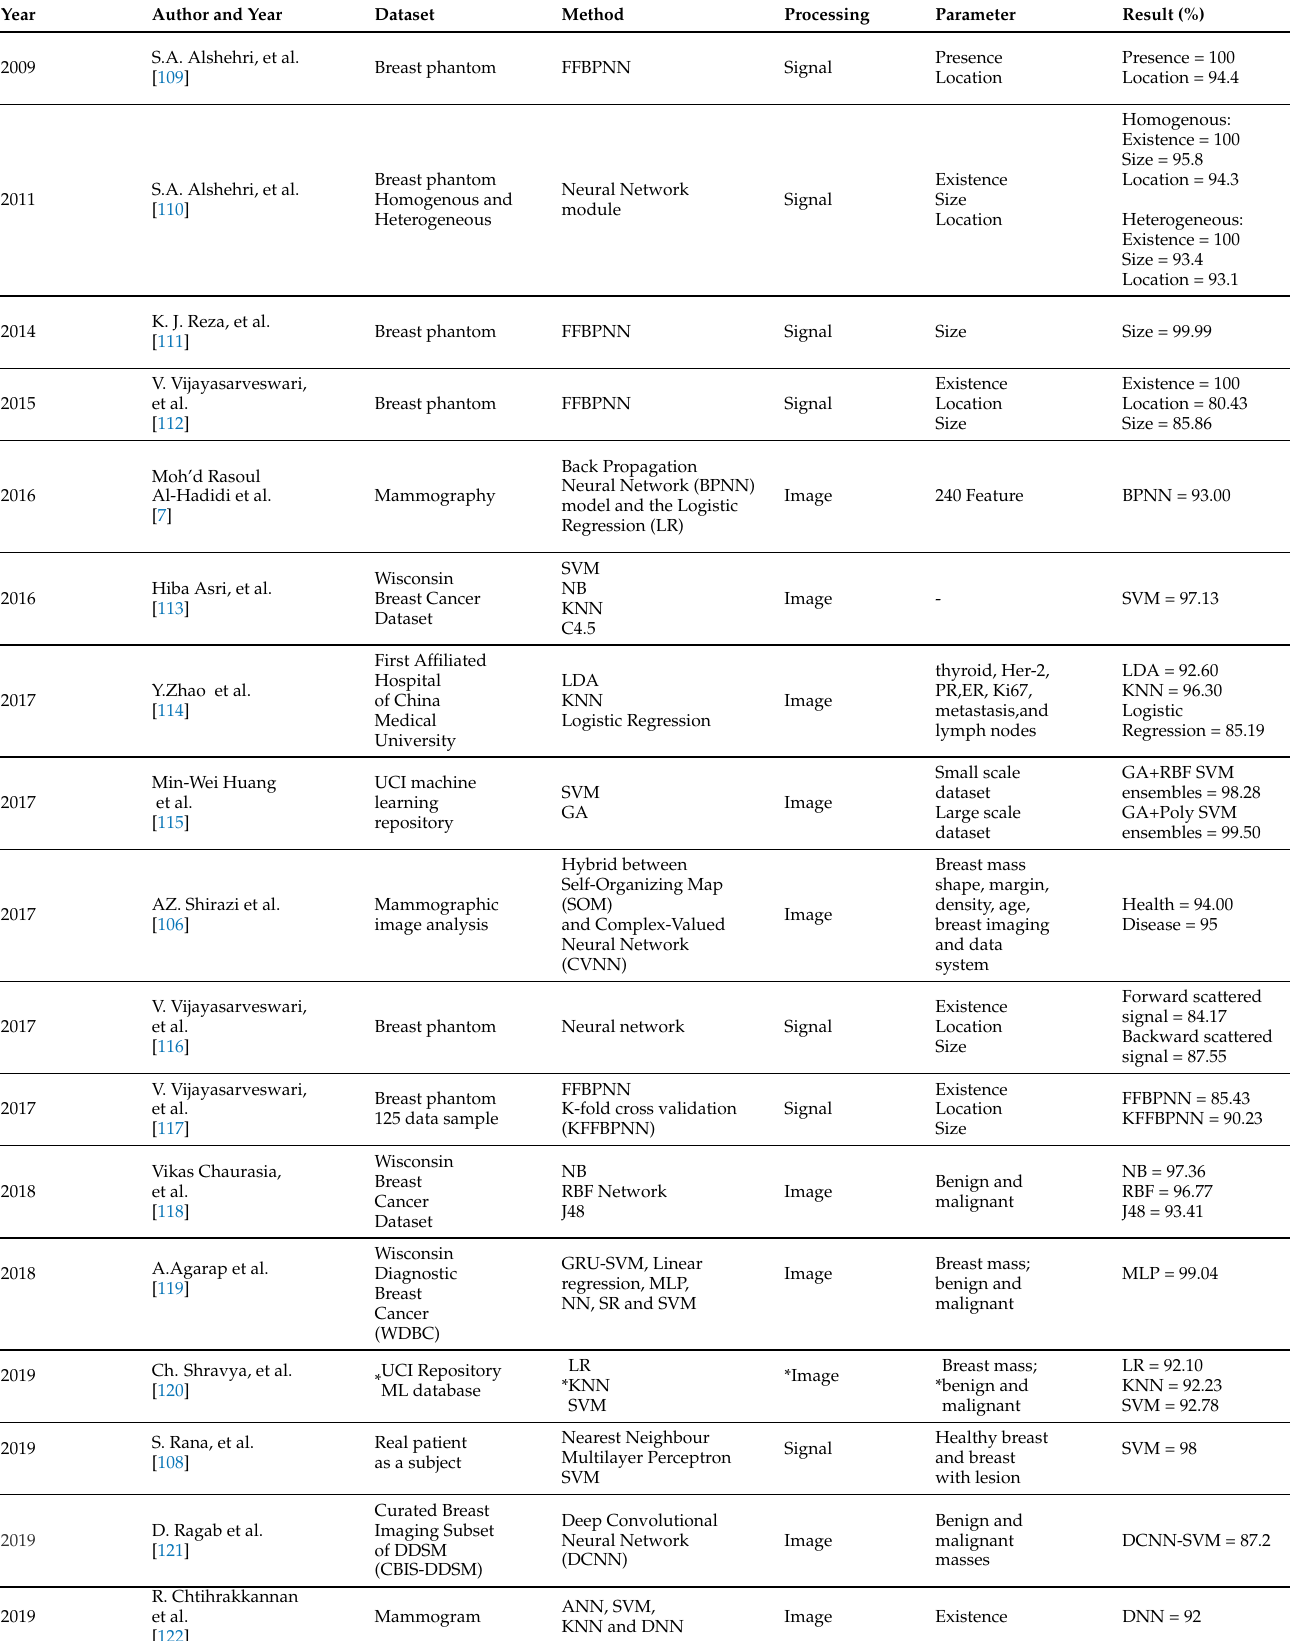
Table 6. Summary comparative table on machine learning in breast cancer